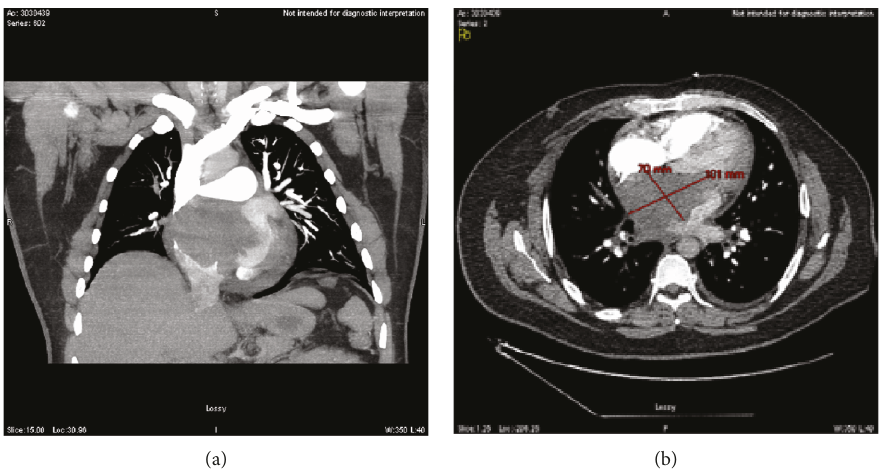
Figure 2: Computed tomography of the chest demonstrating the mass in the left